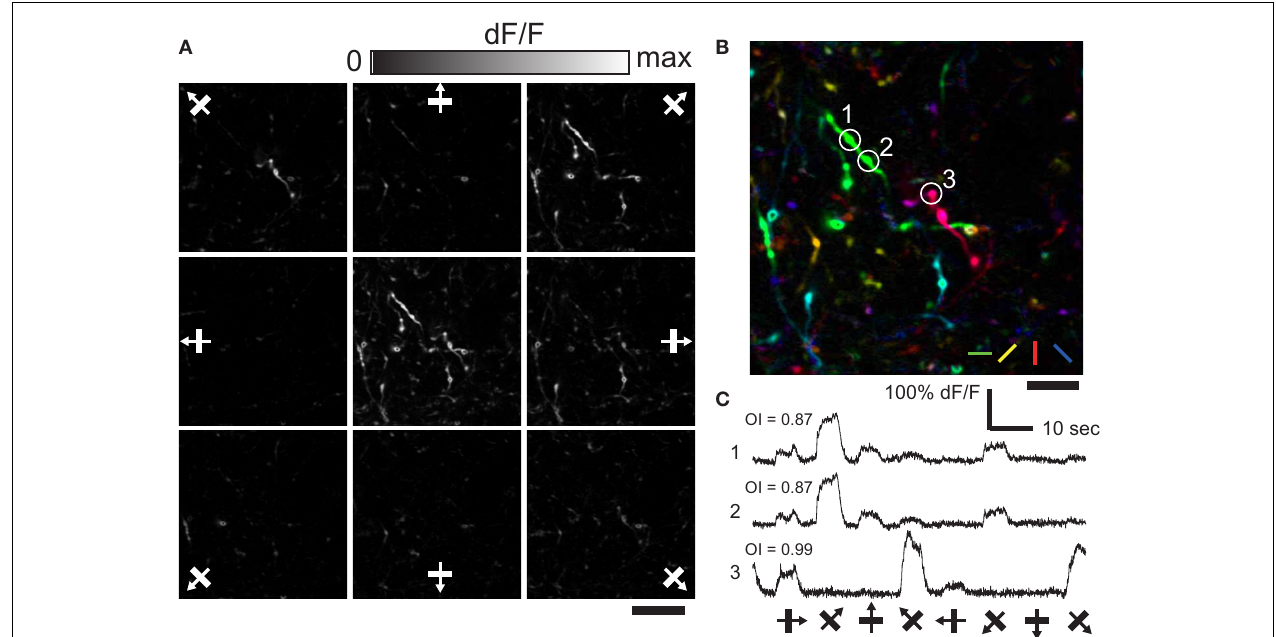
FIGURE 2 | Orientation and direction selective response of axonal boutons in LM. (A) Representative single condition (cid:2) F/F maps for eight directions. Center panel shows max (cid:2) F/F. Scale bar, 20 µ m. (B) Color-coded